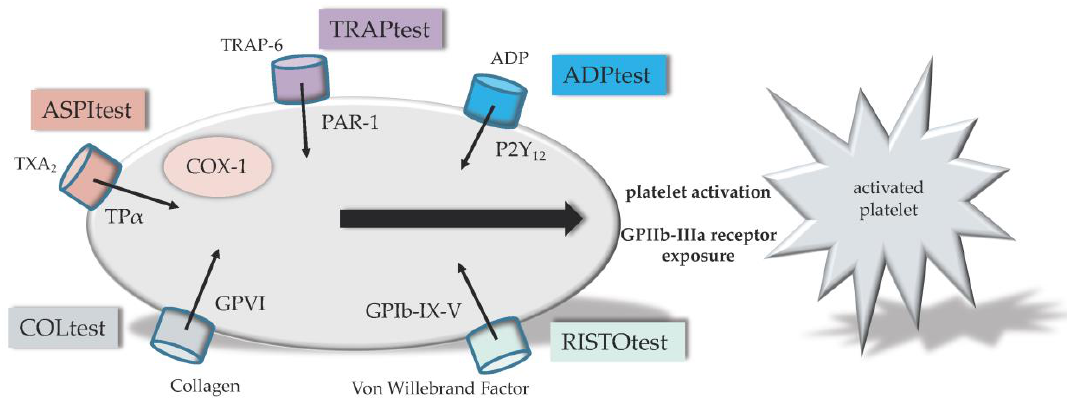
Figure 6. Illustration of Multiplate ® tests. The ADPtest detects platelets after stimulation of adenosine diphosphate (ADP) receptor pathway P2Y 12 . The TRAPtest detects platelets after stimulation with the agonist thrombin receptor activating peptide (TRAP) of the protease activated receptor-1 pathway (PAR-1). The RISTOtest detects platelets after stimulation with the agonist ristocetin of the glycoprotein Ib-IX-V (GPIb-IX-V) receptor pathway. The ASPItest detects platelets activated by arachidonic acid (AA). AA is finally converted to thromboxane A 2 (TXA 2 ) by cyclooxygenase-1 (COX-1) and others. The COLtest detects platelets activated by AA, too. Collagen is added to the sample and stimulates the collagen receptor glycoprotein VI (GPVI) pathways. No direct Glycoprotein IIb-IIIa (GPIIb-IIIa) receptor measuring.